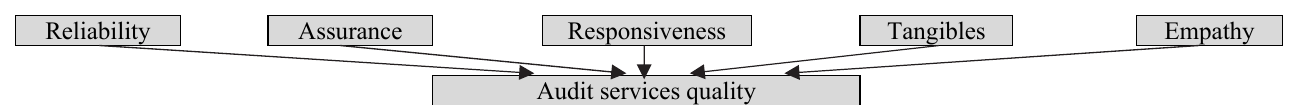
Fig. 1. Proposal model for audit services quality in Vietnam